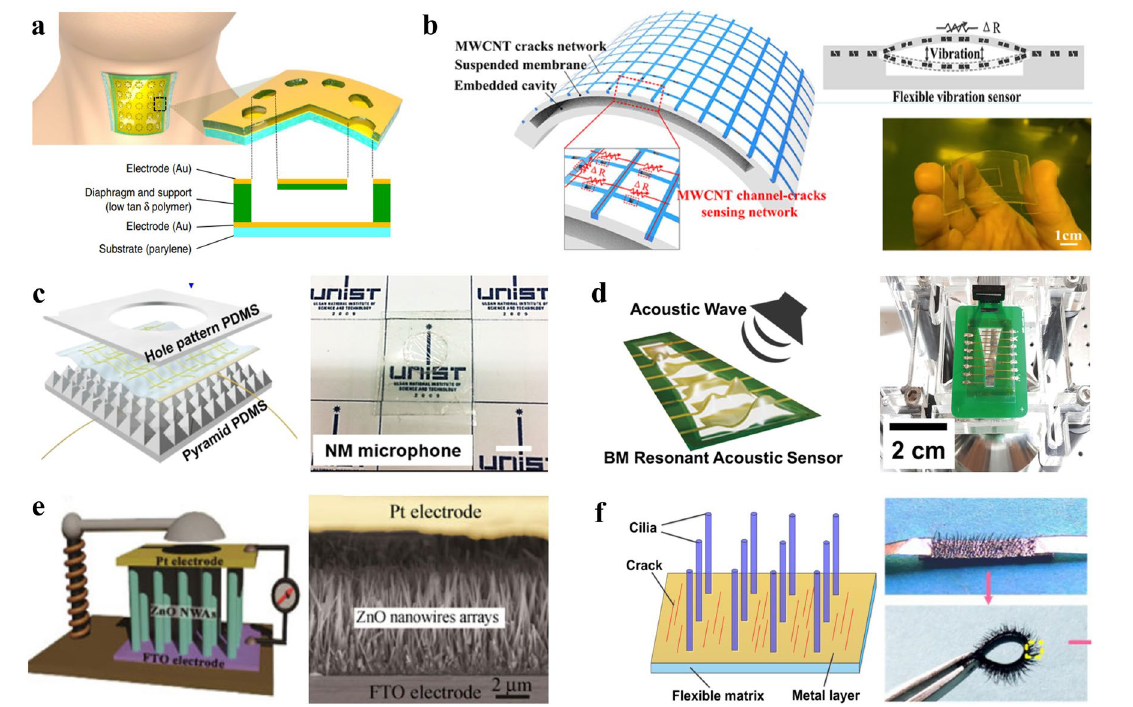
Fig. 6 Typical design strategies of flexible vibration sensors. a An ultrathin polymer film and a hole-patterned diaphragm structure [97]. Copy- right (2019) The Authors. b A channel-crack-sensing membrane on a cavity substrate [129]. Copyright (2021) American Chemical Society. c A freestanding hybrid nanomembrane on a holey PDMS film and micro pyramid-patterned PDMS film [140]. Copyright (2018) The Authors. d A thin PZT membrane on a printed circuit board with a curved shape hole [136]. Copyright (2018) Elsevier. e ZnO nanowire arrays sandwiched by two electrodes [133]. Copyright (2013) Springer Nature. f Cilium arrays on cracked metal layers [134]. Copyright (2020) American Chemical